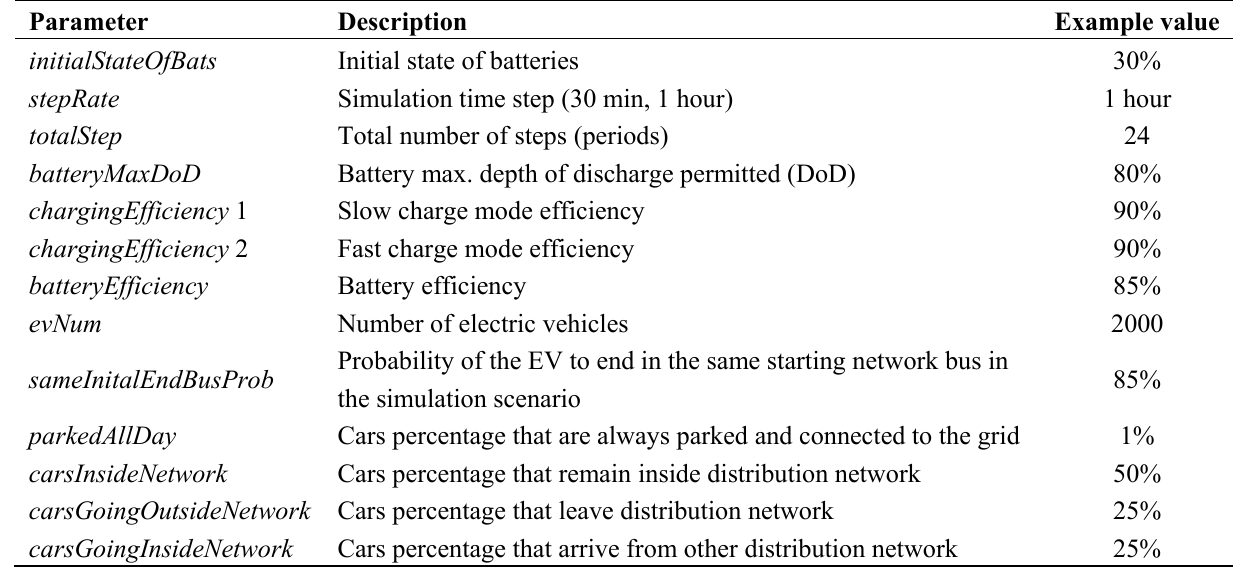
Table 2. EVeSSi global parameters.